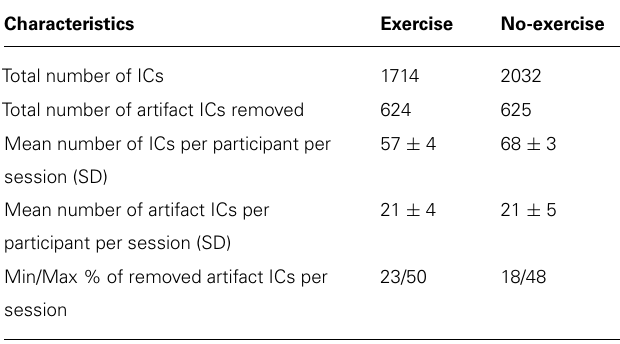
Table 2 | Details ofVISTAR IC